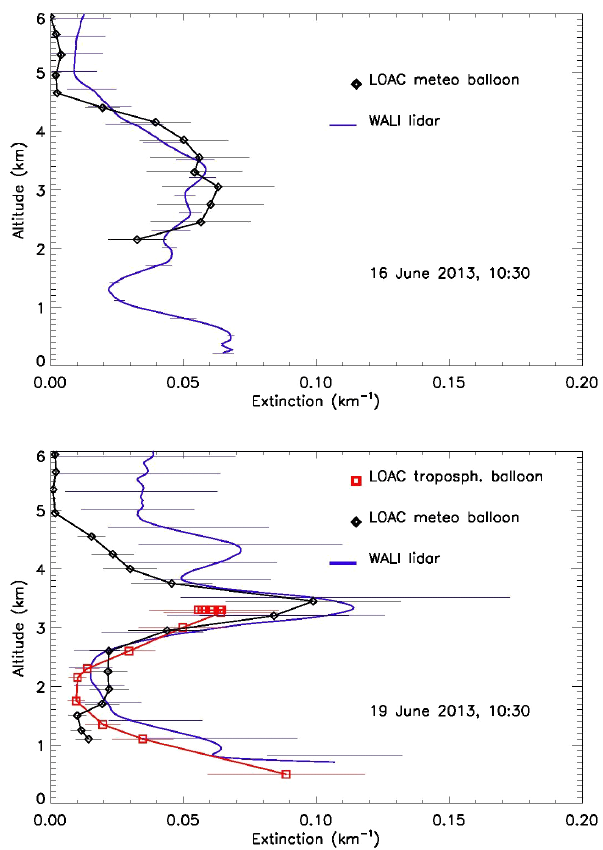
Figure 15. Extinction profiles of the WALI lidar and extinction profiles calculated from LOAC measurements under meteorological and pressurized tropospheric balloons, from Minorca Island during the ChArMEx